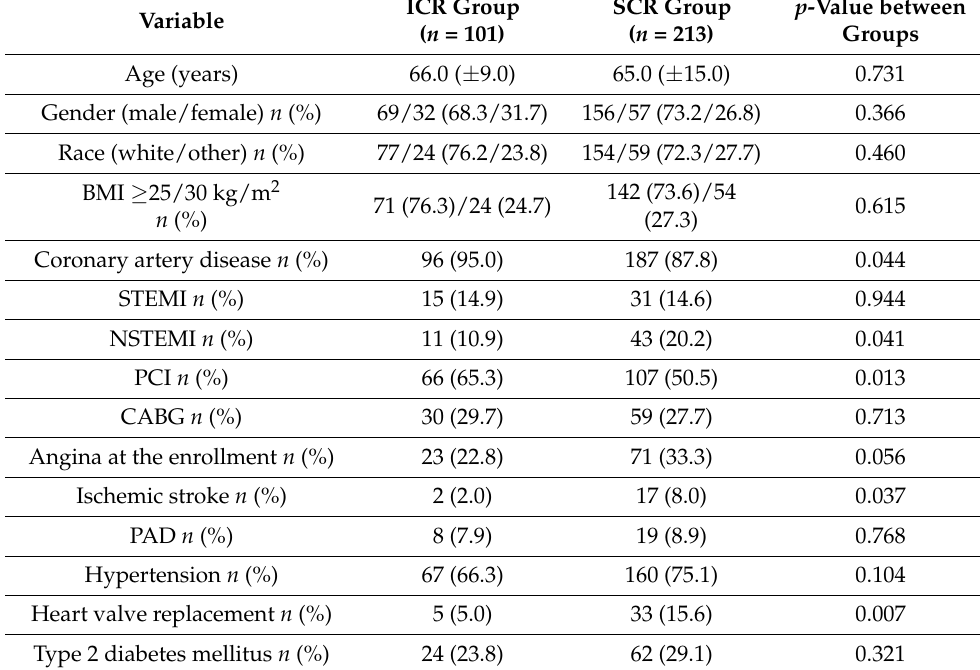
Table 1. Baseline clinical characteristics of patients undergoing intensive cardiac rehabilitation (ICR group) and standard cardiac rehabilitation (SCR